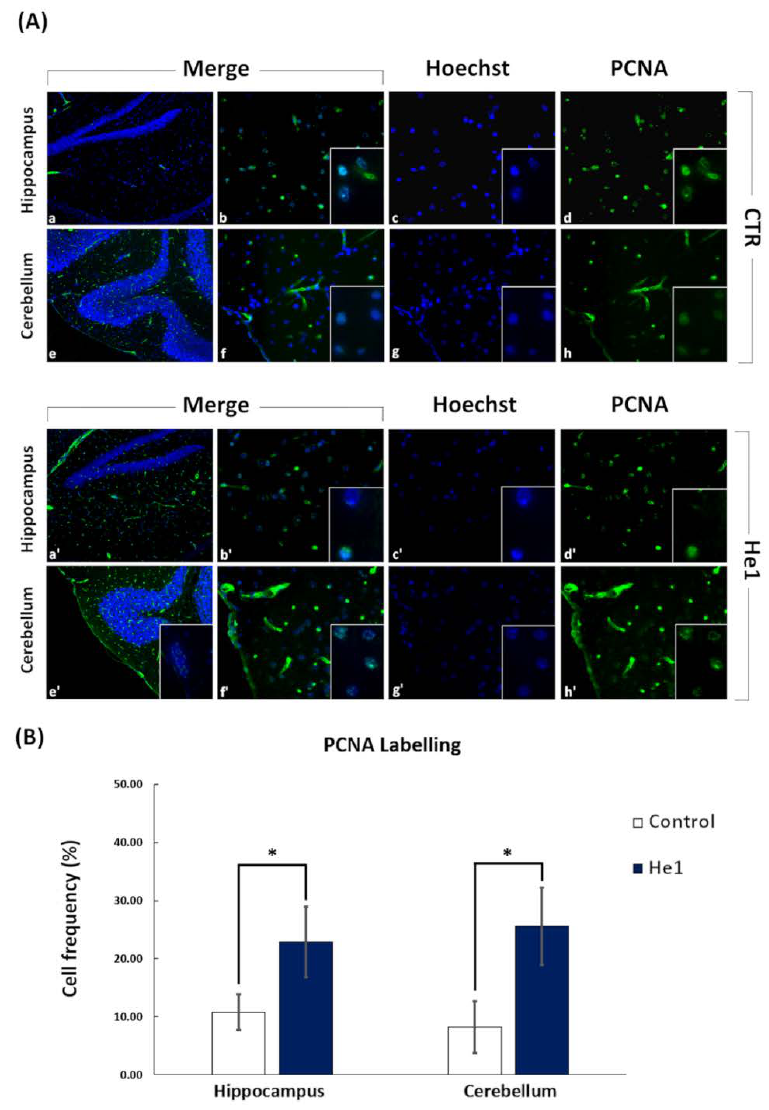
Figure 9. Panel ( A ) shows cell proliferating activity immunocytochemically detected by PCNA (Proliferating Cell Nuclear Antigen) labelling, observed at T5 after 2 months oral supplementation with He1 in both hippocampus and cerebellum, (a’–d’ and e’–h’, respectively), compared to control untreated mice (CTR) (a–h). Cell proliferation was significantly enhanced in He1 mice, with the labelling appearing more intense in the hippocampal DG granule cells and in CA3 pyramidal neurons (a’–d’) and in cerebellar molecular layer (e’–h’), compared to controls (a–d and e–h, respectively), predominantly localized in the DG granule cells and in CA3 pyramidal neurons, as also in the width of the cerebellar. Objective magnification: 20 x (a, e and a’, e’); 40 x (b–d, f–h and b’–d’, f’–h’); 100 x (insert in b–d, f–h, b’–d’, f’–h’). Panel ( B ) shows changes in the percentage of PCNA labelling index of hippocampal and cerebellar cells in He1 mice. p < 0.05